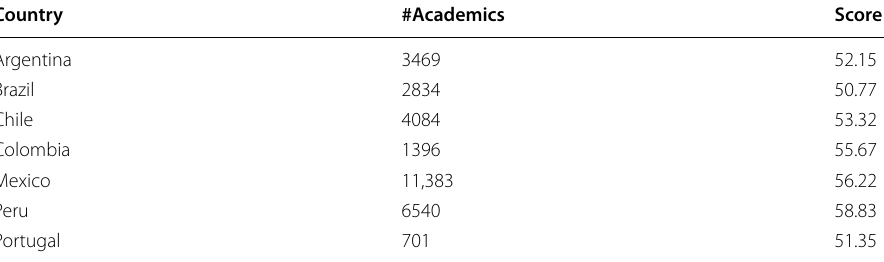
Table 1 Number of participants per country and their average score Country